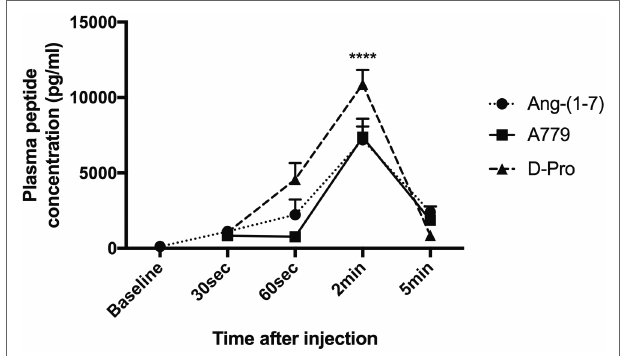
FIGURE 7 | Plasma concentrations of Ang-(1-7) peptide (10 μ g/kg) and peptide receptor blockers A779 (10 μ g/kg) and D-Pro (10 μ g/kg) after a bolus injection of intravenous administration. Each time point represents the mean ± SEM profile from 4 rats per treatment group. **** p < 0.005 concentration of each peptide at 2 min vs.